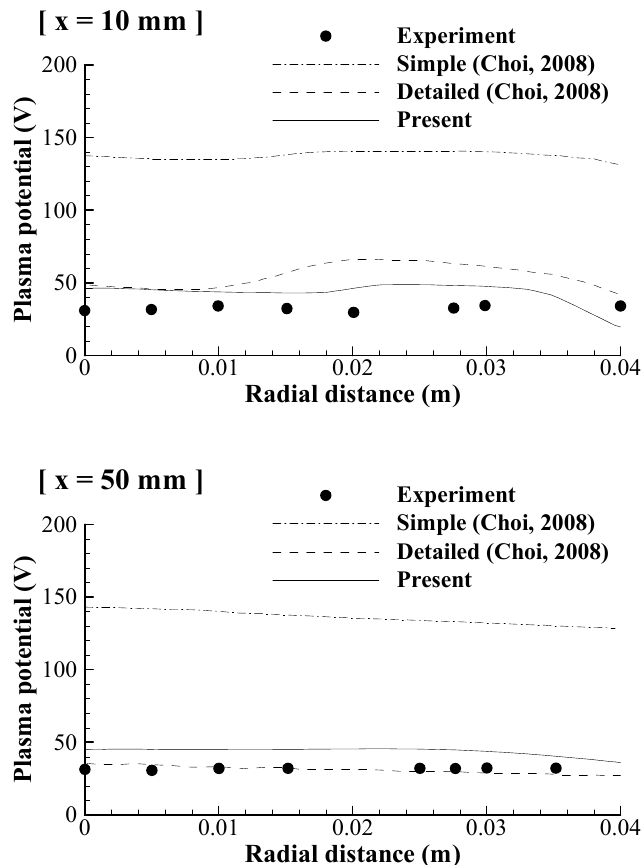
Figure 5. Radial profiles of the plasma potential for Case 1.